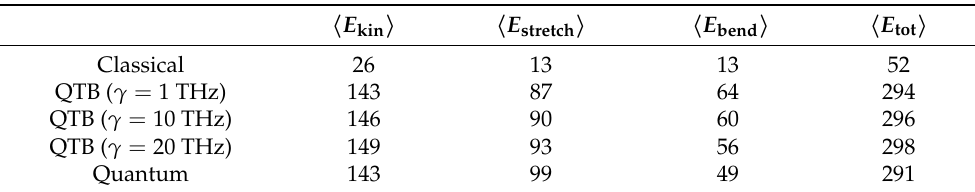
Table 1. Average energies for the 2D model of O–H bond at 300 K (energy values in meV). Quantum results are obtained from a PIMD simulation with 96